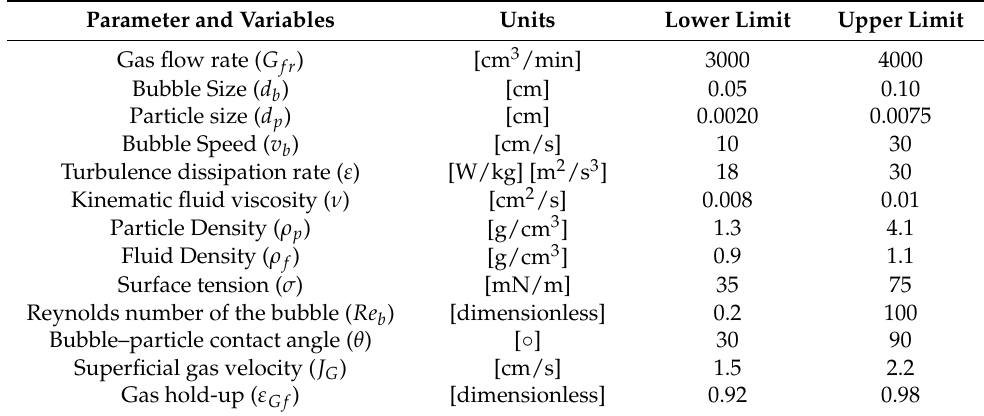
Table 1. Schematic summary of the independent